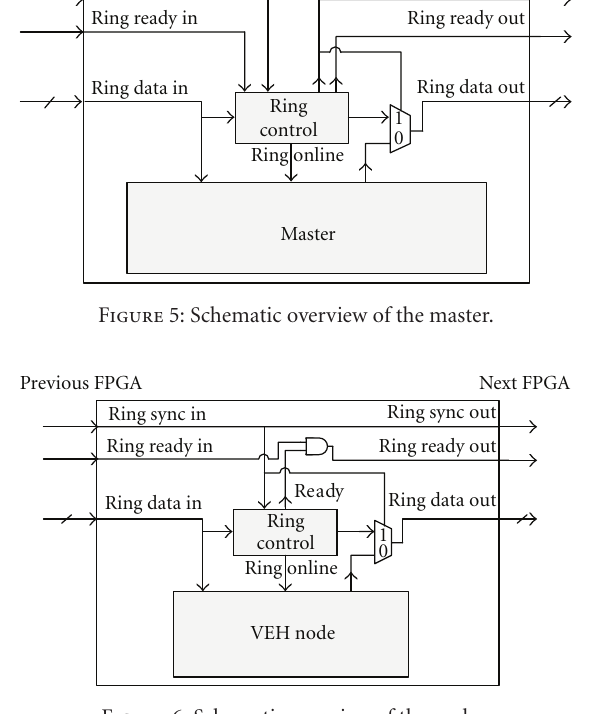
Figure 6: Schematic overview of the